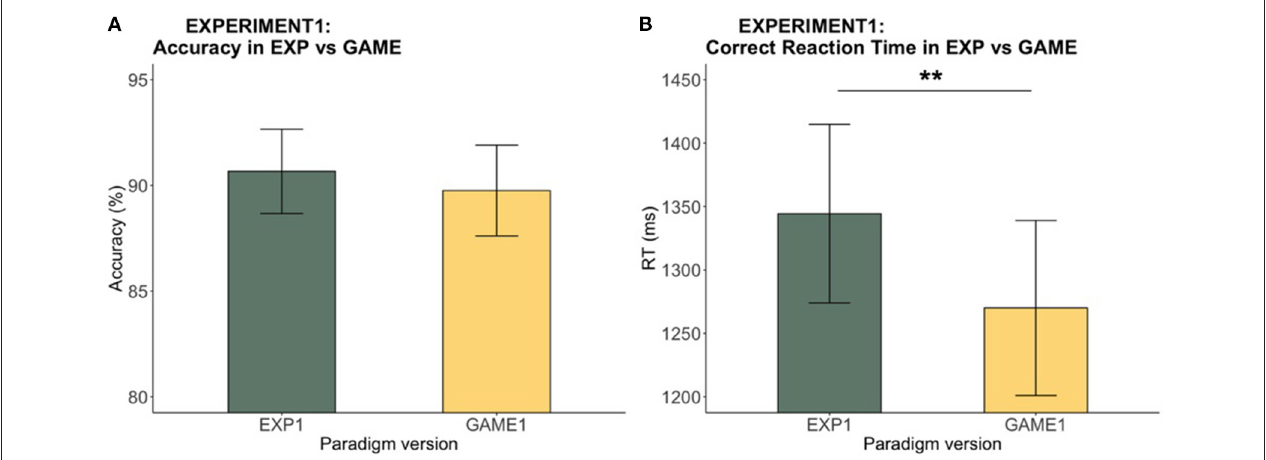
FIGURE 4 | Experiment 1: Experiment vs. game accuracy and RT. The bar chart indicates (A) the mean accuracy and (B) the mean RTs across participants while the error bars shows the 95% confidence intervals. RT of the game was significantly faster than that of the experiment (** p <